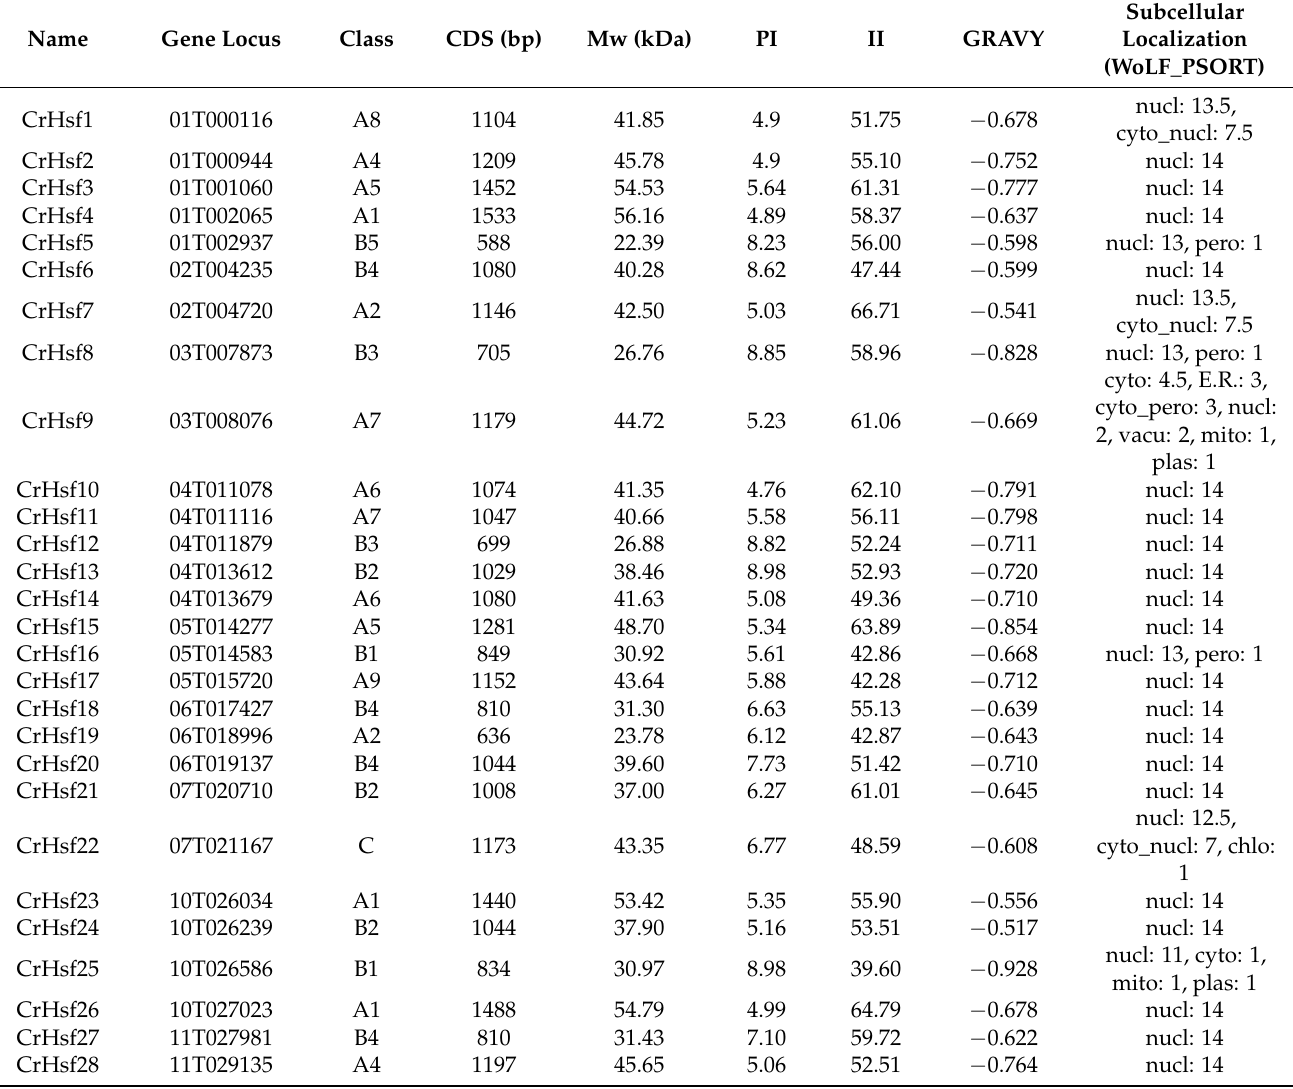
Table 1. Nomenclature of heat shock transcription factor genes and subcellular localization of the coding proteins identified from the Canavalia rosea